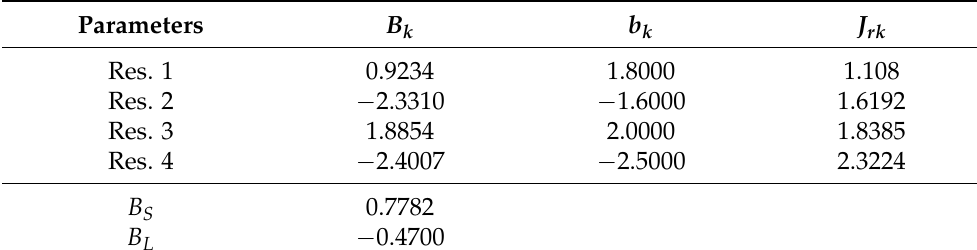
Table 4. Extracted elements of the 4th-order filter prototype with a Ω Ek TZs distribution.